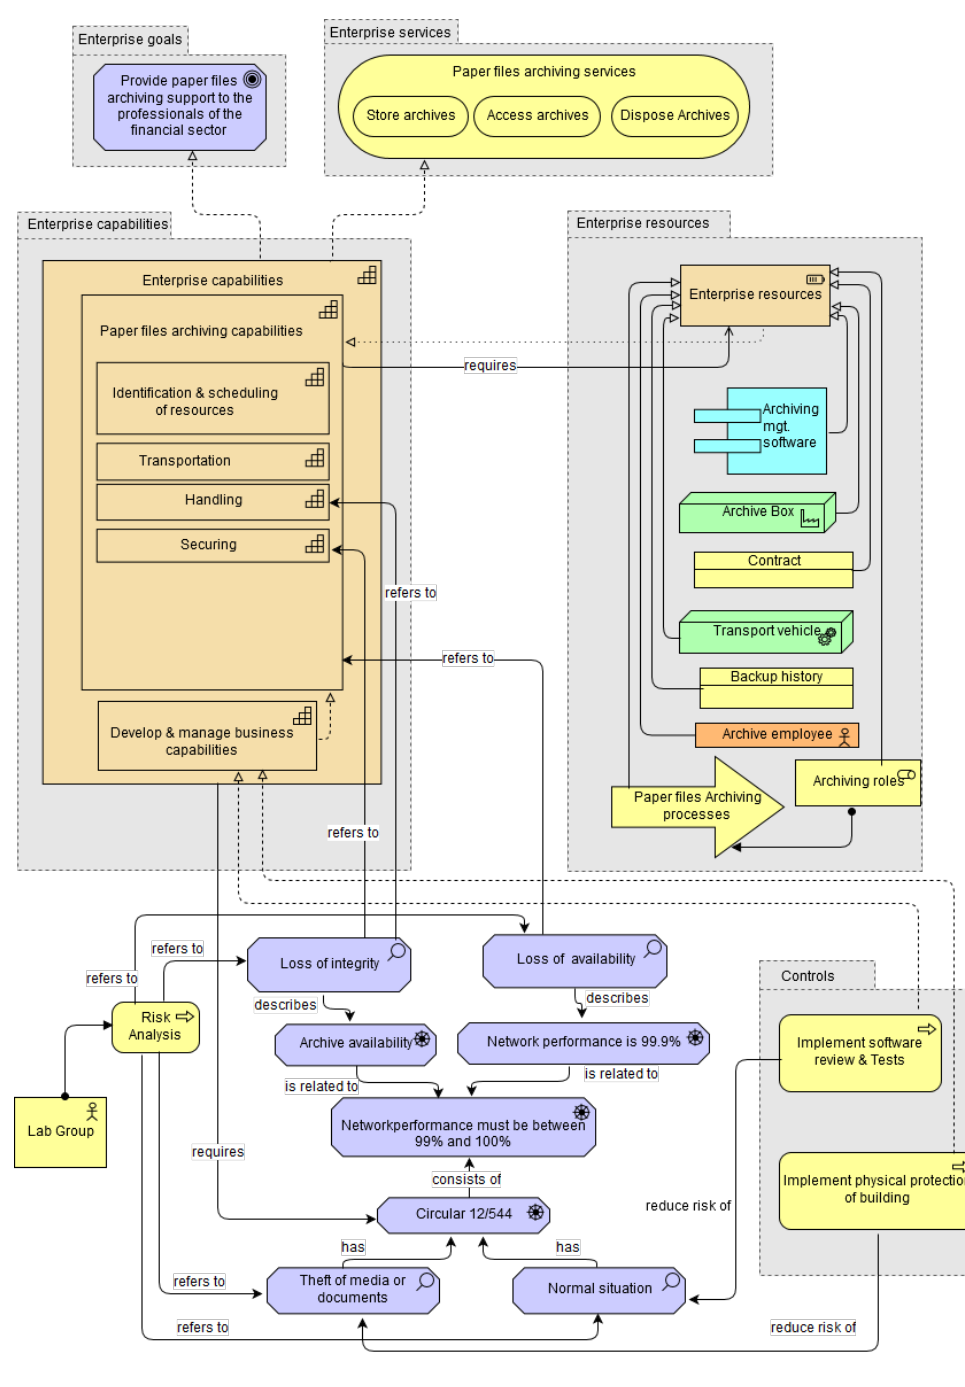
Figure 7. Use case: Paper files archiving